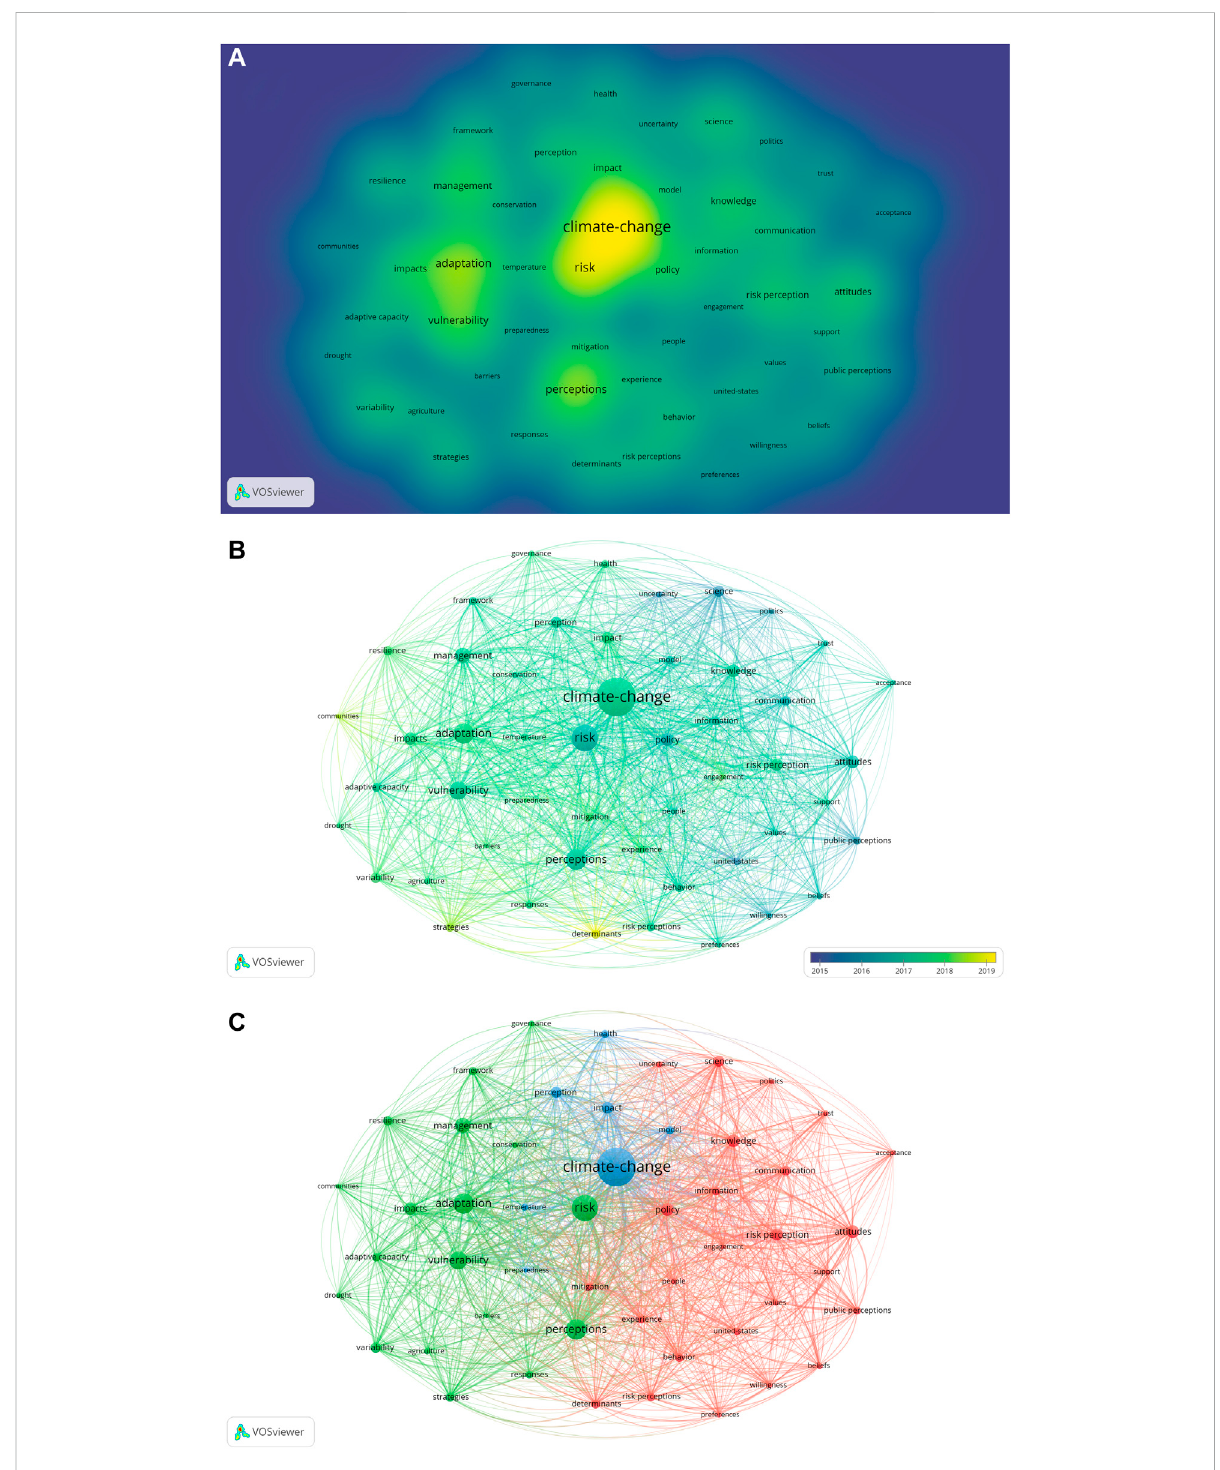
FIGURE 6 The Density (A) , overlay (B) and network (C) visualization map of keywords